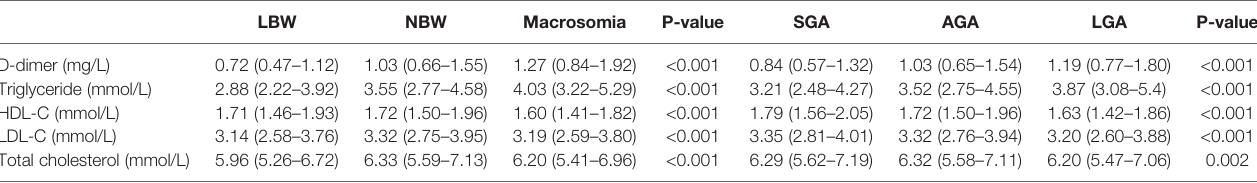
TABLE 2 | Maternal D-dimer and blood lipid levels before childbirth according to the birthweight.